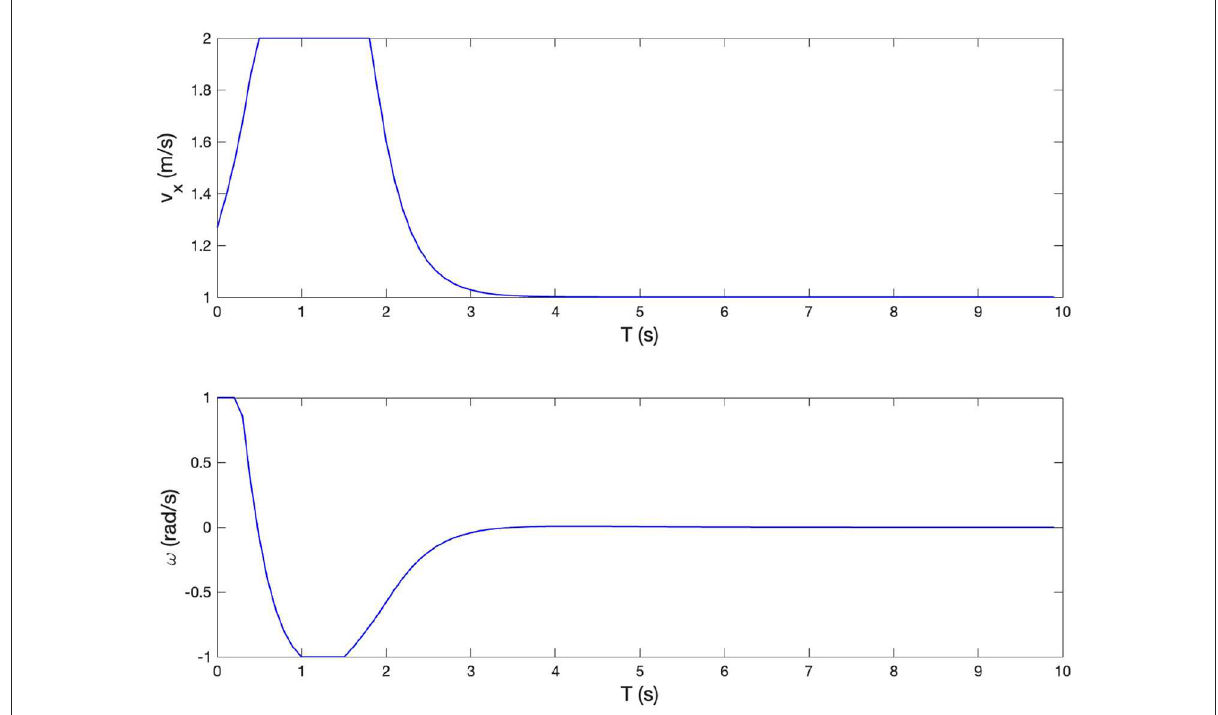
FIGURE10 The longitudinal velocity and yaw velocity of the baby stroller.